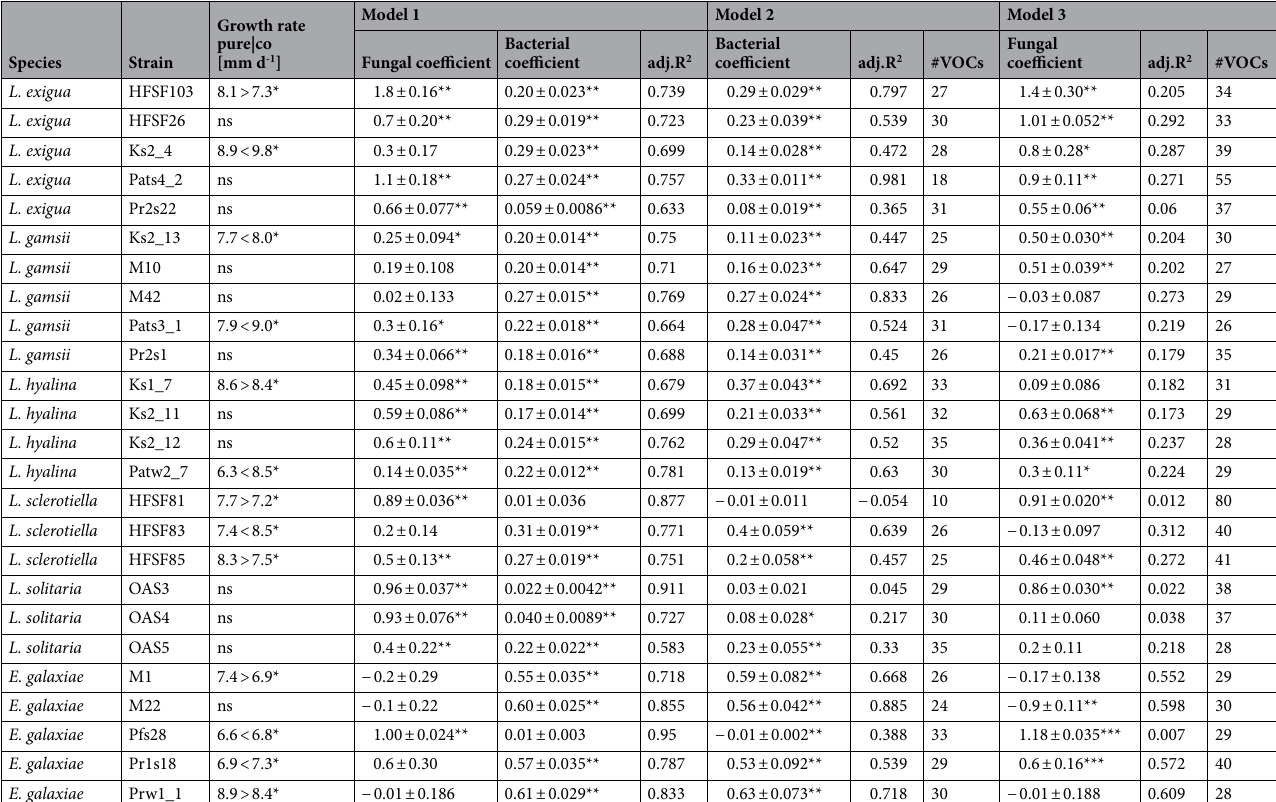
Table 2. Linear models predicting the volatilome contribution of Pseudomonas helmanticensis and Mortierellaceae strains in co-cultures. Three models were calculated: (1) Co-culture volatilome predicted from both, fungal and bacterial pure cultures. All volatile organic compounds (VOCs) detected were used for prediction. (2) Co-culture predicted from pure P. helmanticensis cultures. The model considers only VOCs never produced/consumed in the respective fungal pure culture, but produced in P. helmanticensis pure cultures. (3) Bacterial contribution to the volatilome was predicted from model (1) and subtracted from the measured concentrations in the co-cultures. From this predicted volatilome, the fungal contribution to the co-culture volatilome was modelled. In none of the three models calculated, the intercept differed from zero. The coefficient of the equation can be considered as a proxy for the bacterial and fungal contribution to the co-culture volatilome, respectively, and indirectly for growth. Coefficient ± standard error. #VOCs = number of VOCs considered in the model. Significances: ns = not significant; * = p < 0.05; ** = p <